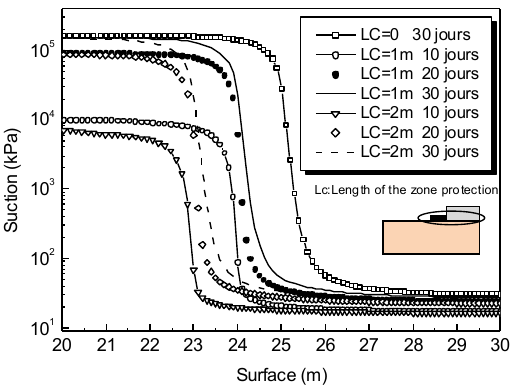
Figure 11b. Influence of the protection area on the varition of the suction at the ground surface Figure 12b. Water retention curves considred in the parametric study. suction augments up to 1 MPa at depth z = 1 . 1 m and only to 100 kPa at z = 1 . 75 m; thereafter the suction remains approx- imately constant in the range 40–70